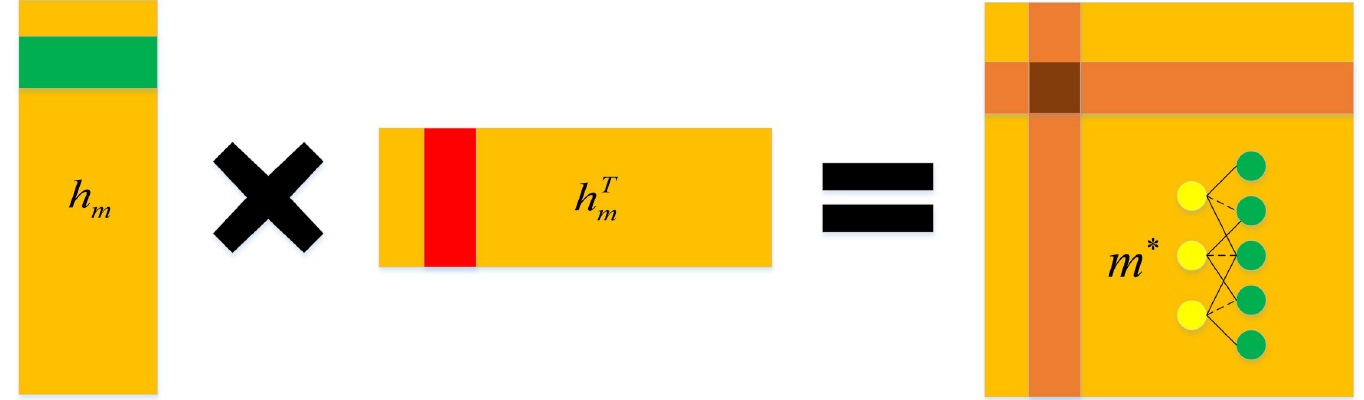
Fig 4. The overview of inner project in decoder.